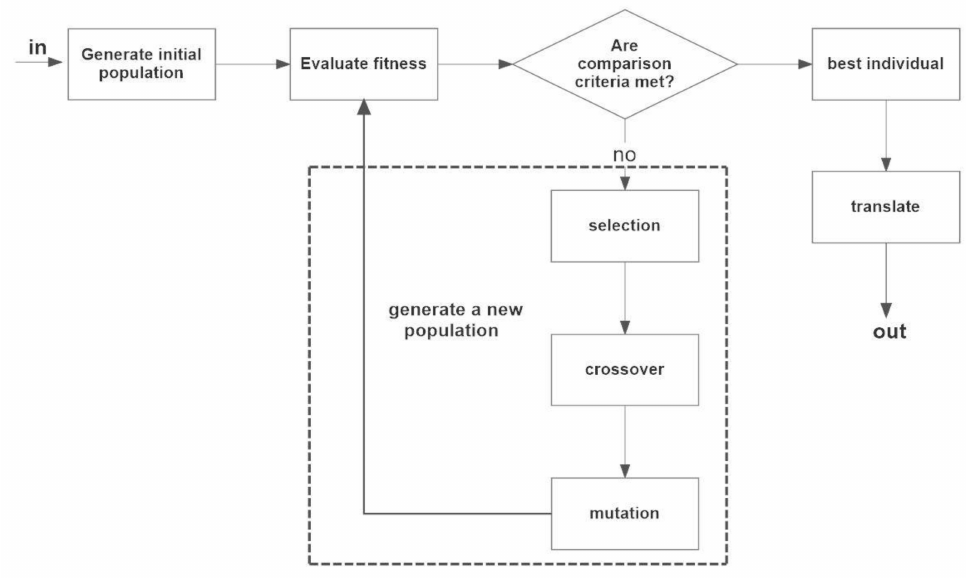
Figure 6. Standard procedure of a canonical genetic algorithm [25].